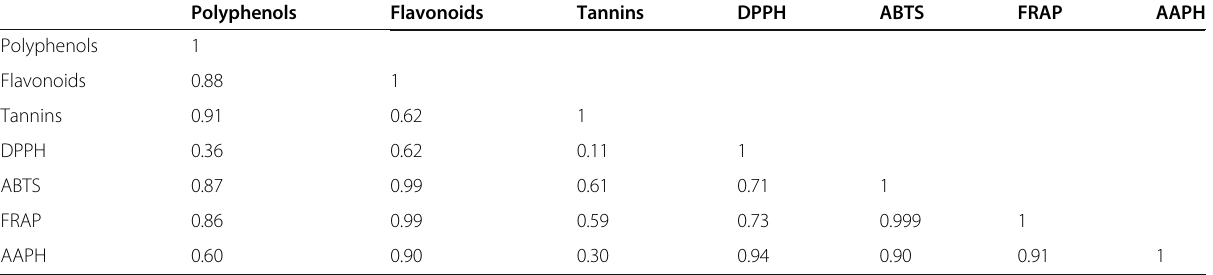
Table 4 Correlation between ABTS, FRAP, DPPH, AAPH, polyphenols, flavonoids, and tannins